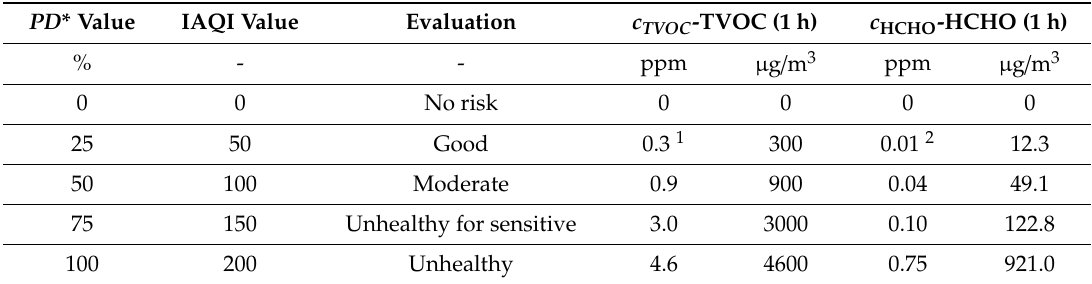
Table 7. Recalculation and conversion of IAQI value scales.